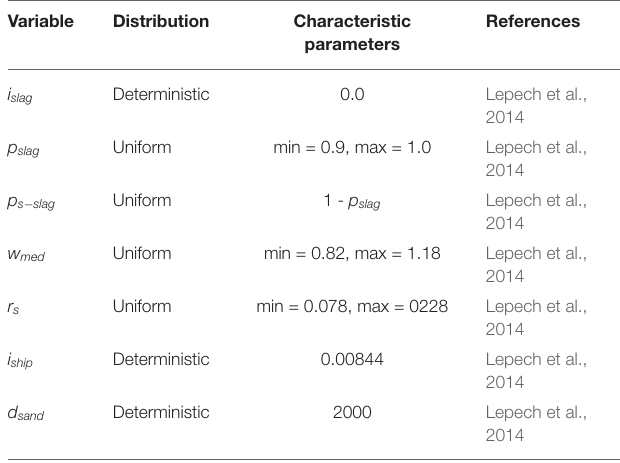
TABLE 6 | Sandblasting environmental impact modeling variables, distributions, and